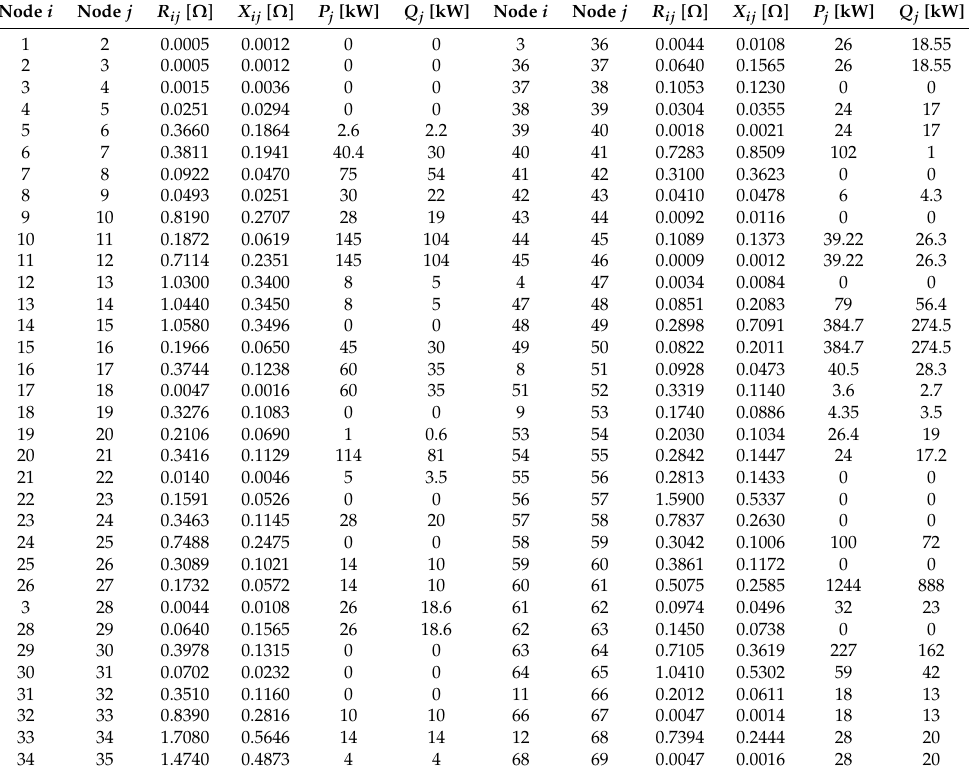
Table 2. Branch and nodal information in the 69-nodes test feeder.